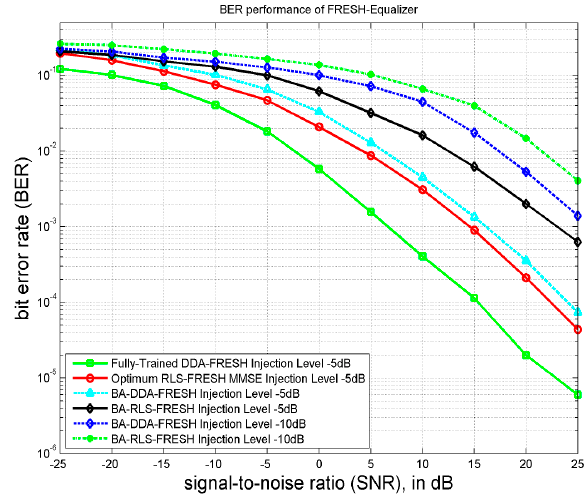
Figure 4. BER performance comparison between RLS based and DDA based Cyclic FRESH Equalizers for injection levels − 5 dB and − 10